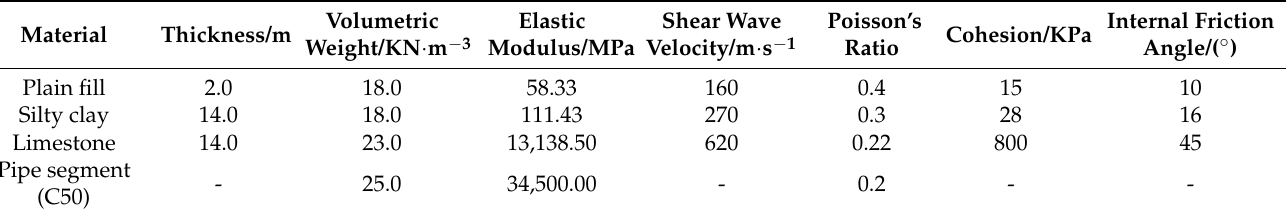
Table 1. Physical and mechanical parameters of